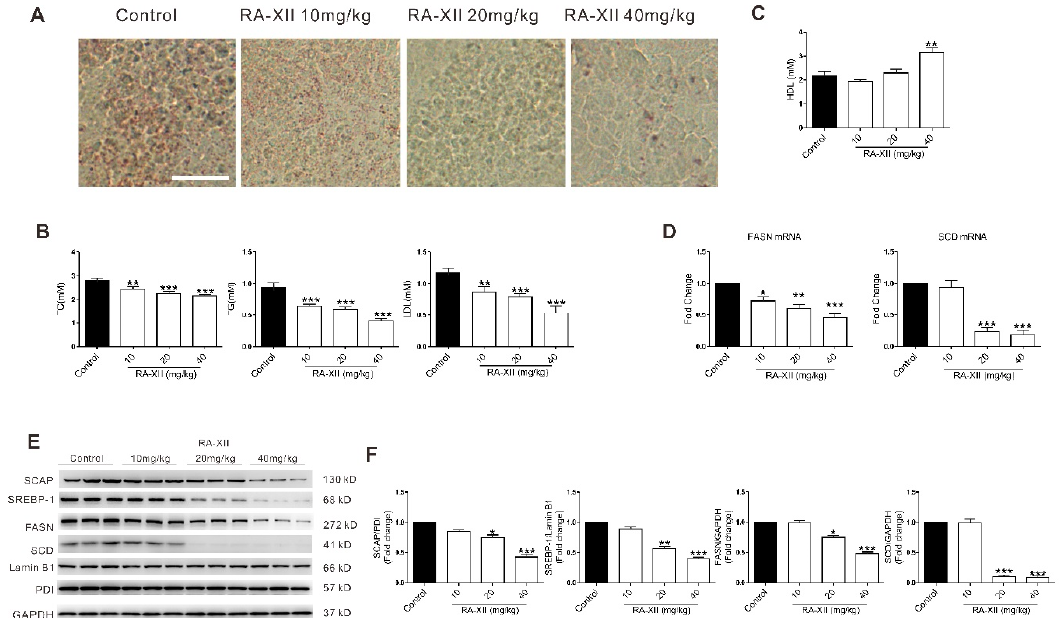
Figure 6. RA-XII exerts lipogenesis inhibition effects on the xenograft mouse model. After treatment with RA-XII for 15 days, mice were sacrificed and solid tumors were isolated. ( A ) Lipid droplet test by Oil Red O staining. Scale bar: 50 μ m. ( B ) Concentrations of TC, TG, and LDL. ( C ) Concentrations of HDL. ( D ) Gene expression of FASN and SCD. ( E ) Protein expression of SCAP, SREBP-1, FASN, and SCD. ( F ) Statistical graphs of protein expression. n = 6. * p < 0.05, ** p < 0.01, *** p < 0.001, compared with vehicle control.